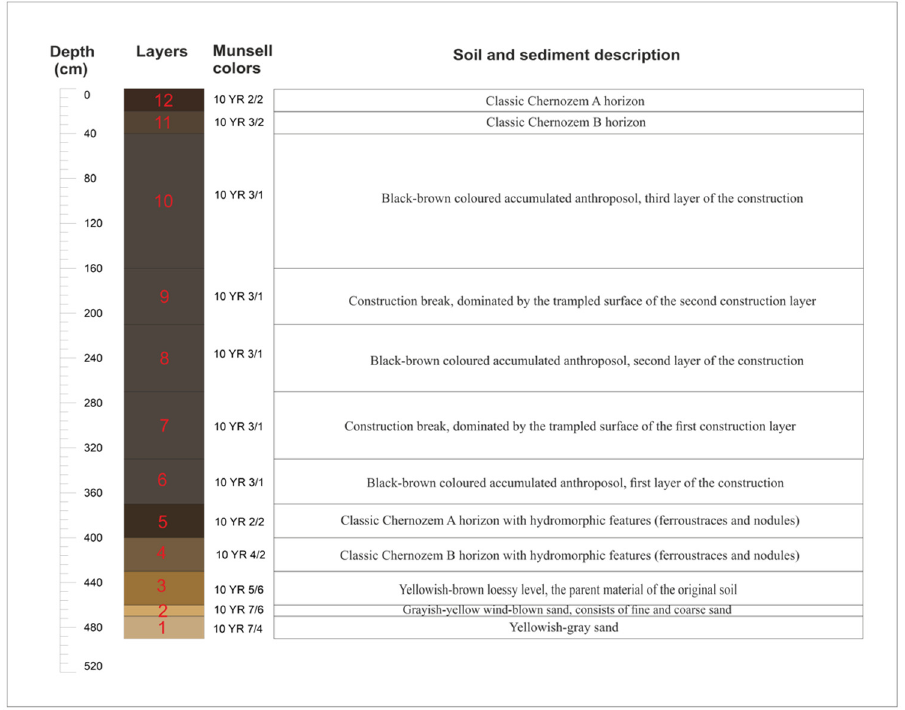
Figure 3. The different strata of the drilling log of the mound with short macroscopic descriptions. Red numbers: (1). Yellowish-gray sandy layer, (2). Grayish-yellow sandy layer, (3). Yellowish-brown loessy layer, (4). Buried soil layer B horizon, (5). Buried soil layer A horizon, (6). First construction layer of the mound (7), The compact-structured, trampled section of the first construction layer, (8). Second construction layer of the mound (9). The compact-structured, trampled section of the second construction layer, (10). First construction layer of the mound, (11). Recent surface soil B horizon, (12). Recent surface soil A horizon. The different layers are colored according to the RGB color of the described Munsell color categories.